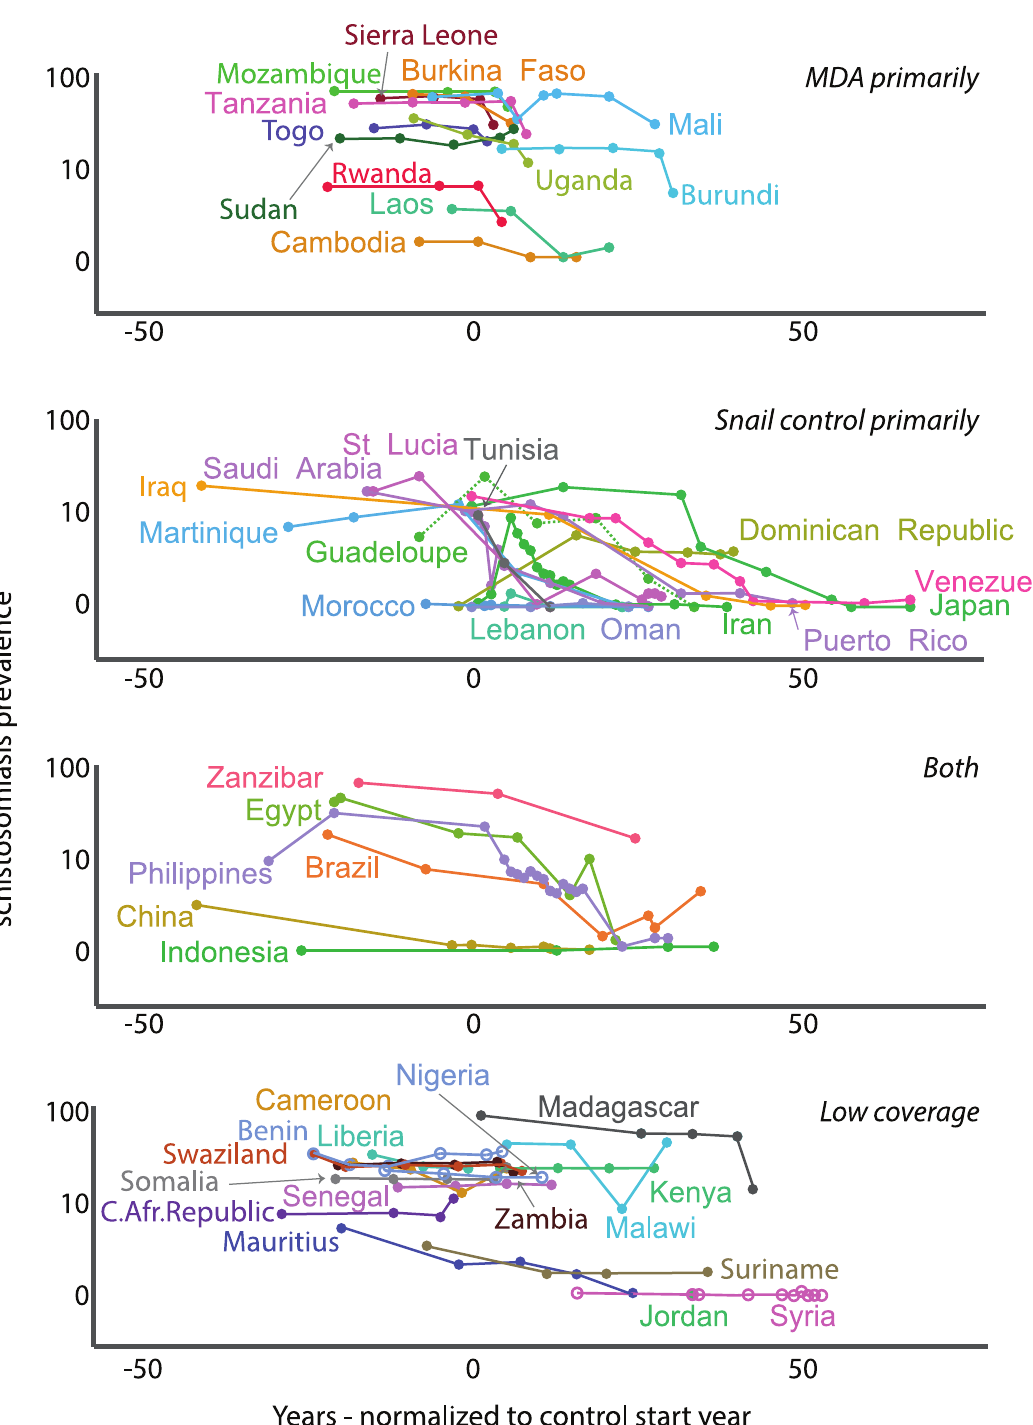
Fig 5. Schistosomiasis prevalence change over time. Prevalence change by control program strategy (time 0 on the x- axis is set when control began; negative values for the normalized year show data n years before control started and positive values n years